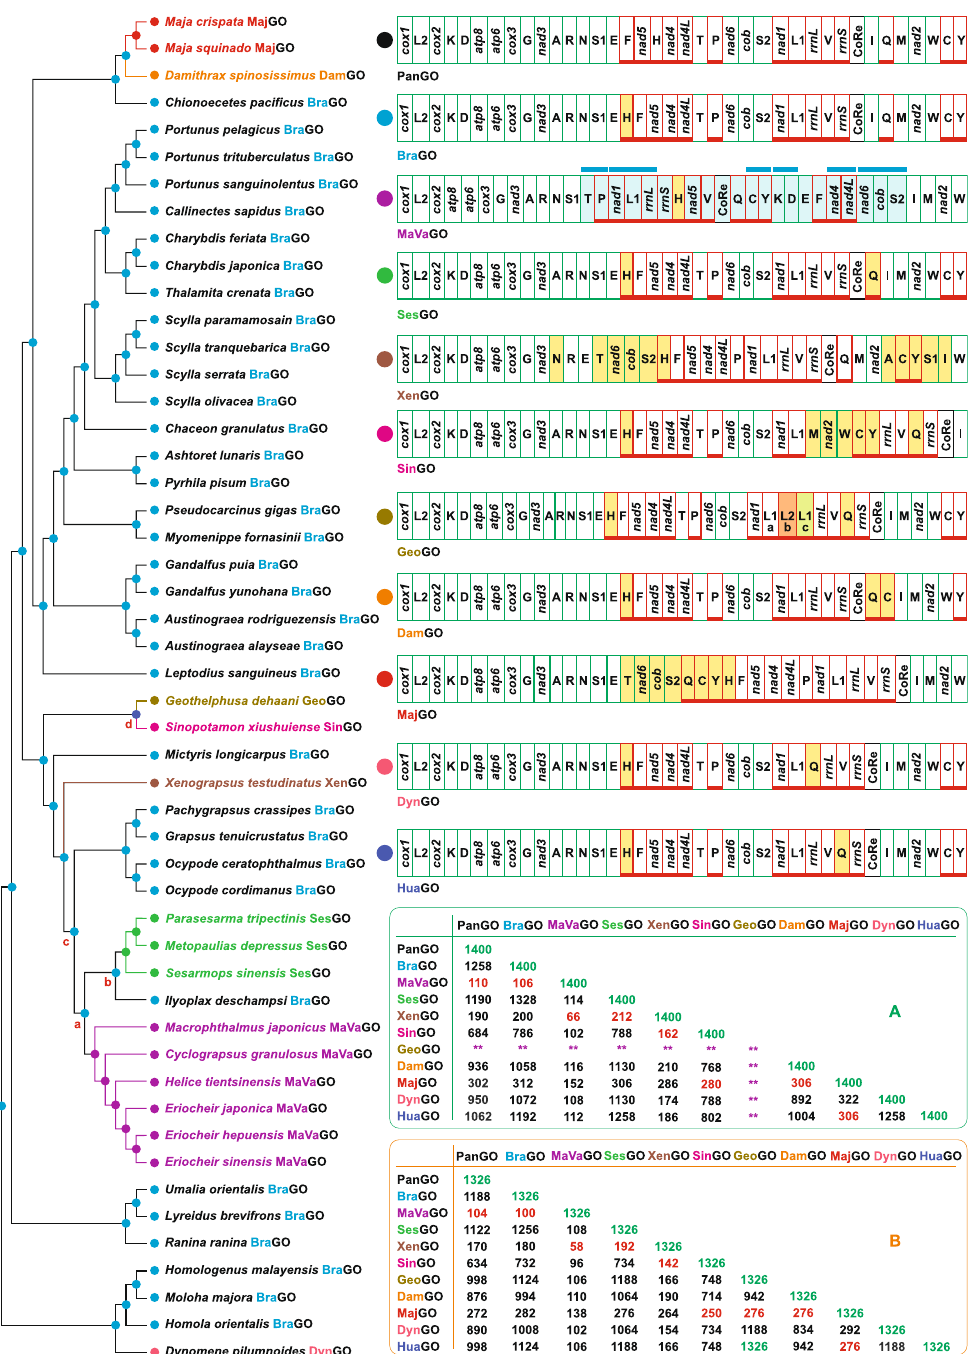
Figure 4. The evolution of mitochondrial gene orders in Brachyura. For most of the nodes the GO was inferred directly with the program TreeREx. For nodes a–d, the GO assignment was performed manually (see main text). L2b, derived from a tRNA remoulding process, not orthologous to true trnL2s . L1c, extra copy of trnL1 not considered in the TreeREx analysis. Table A, NSCI values computed with CREx program through pairwise-comparisons of complete GOs. Table B, NSCI values computed through pairwise-comparisons of GO deprived of L2s. ** NSCI values not computed (see main text). The genomic and genetic nomenclature, as well as the colour scheme, are the same as in Fig. 1. The genes that changed their position relative to PanGO, through a transposition event, are shown with a yellow background. The passively-shifted genes are figured with their original background. The genes involved in a repositioning, which cannot be identified unambiguously as the result of a transposition or a passive shift, are figured with a light blue background. In this latter case, the common intervals, encompassing two or more genes, shared by the re-arranged GO with PanGO, are highlighted with a light blue